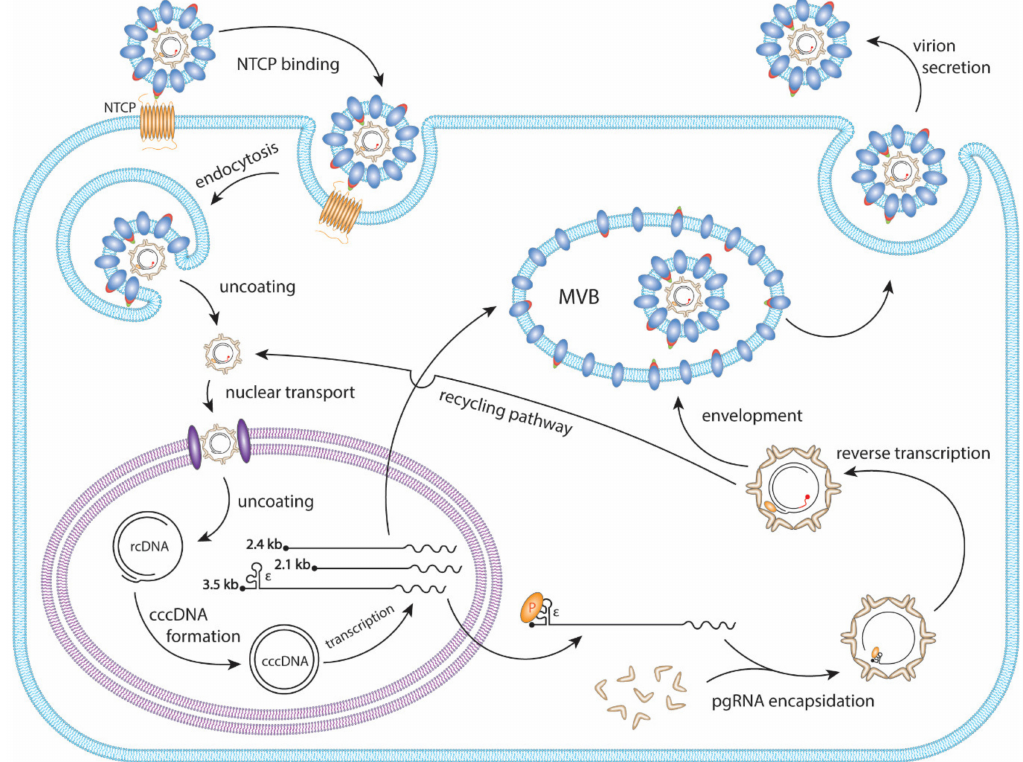
Figure 2. The HBV replication cycle. The HBV virion binds to the hepatic NTCP protein and is endocytosed. The viral membrane then fuses with the endosome, releasing the capsid into the cytoplasm, followed by nuclear import. The rcDNA is released into the nucleus where it uses host DNA repair mechanisms to form cccDNA. Viral mRNAs are transcribed from the cccDNA and are translated to viral proteins. In the cytoplasm, the viral polymerase binds to the epsilon ( ε ) structure of pgRNA and is encapsidated by core proteins. Within the nucleocapsid the pgRNA undergoes reverse transcription to form rcDNA. The mature capsid is enveloped and secreted as a virion particle through the MVB secretory pathway. The mature capsid can also be shuttled to the nucleus where it will amplify cccDNA through a process termed the rcDNA recycling